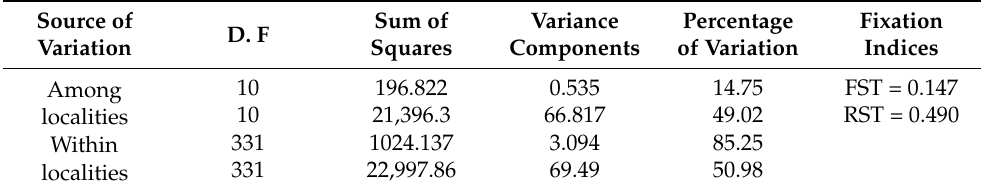
Table 4. Results of the general molecular variance analysis using microsatellites between locations; F ST /R ST